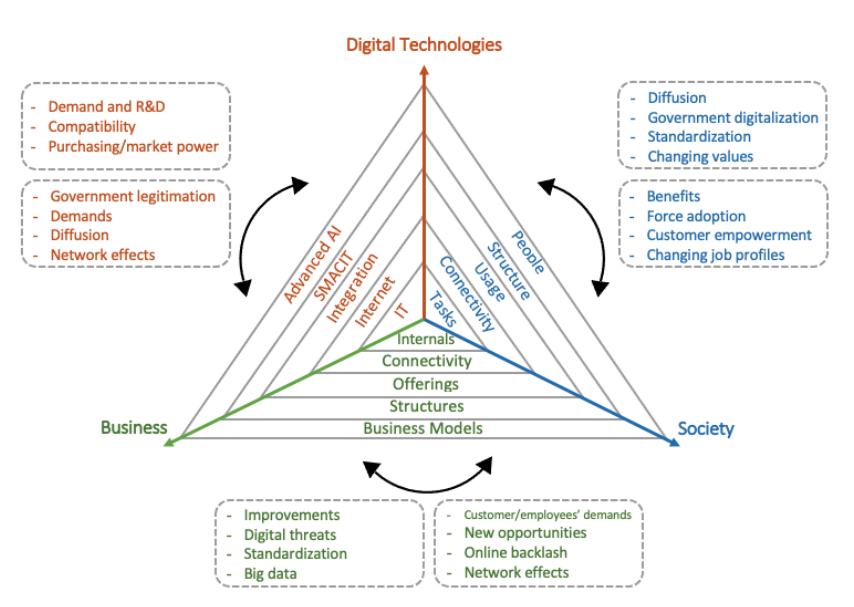
Figure 2. The interaction-based framework for digital transformation (adapted from